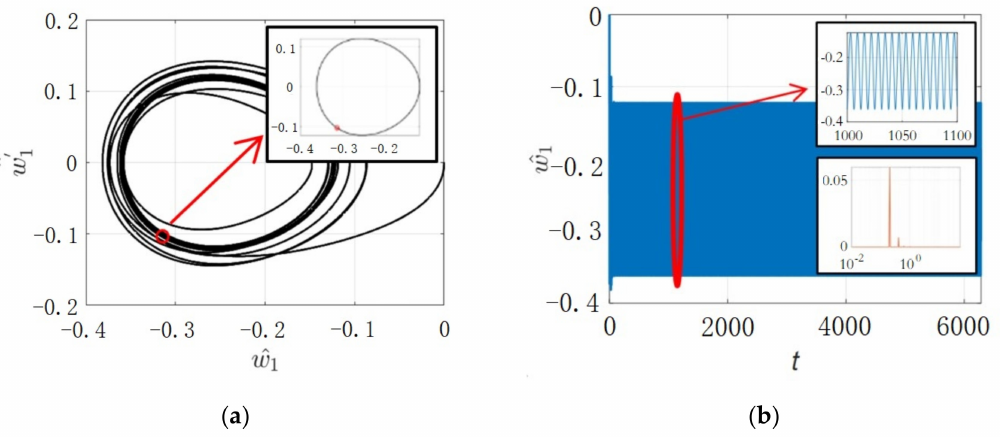
Figure 15. Periodical analysis of vertical displacement: ( a ) Poincar é phase diagram; ( b ) time